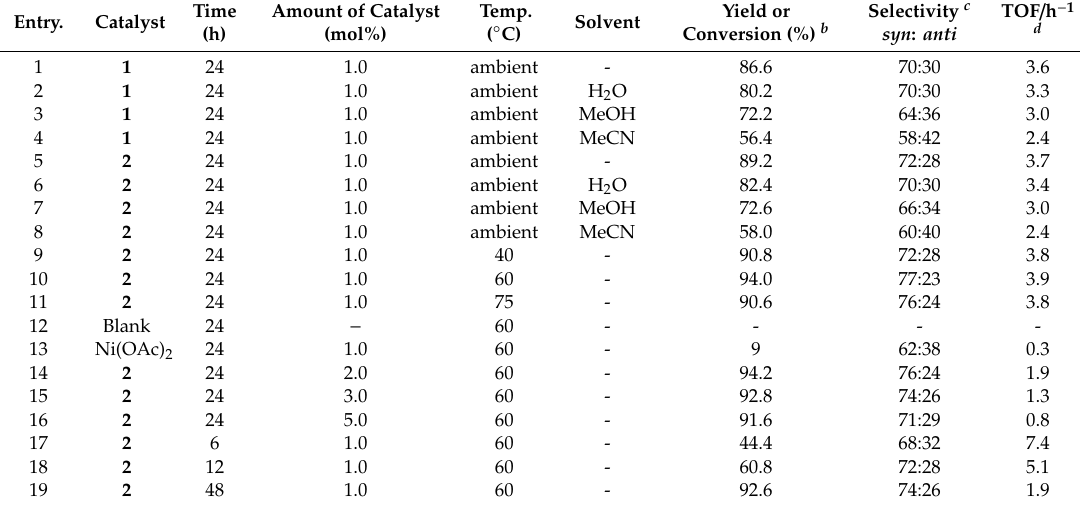
Table 3. Catalytic activity of 1 and 2 in the model nitroaldol condensation reaction a of nitroethane and benzaldehyde. Entry.